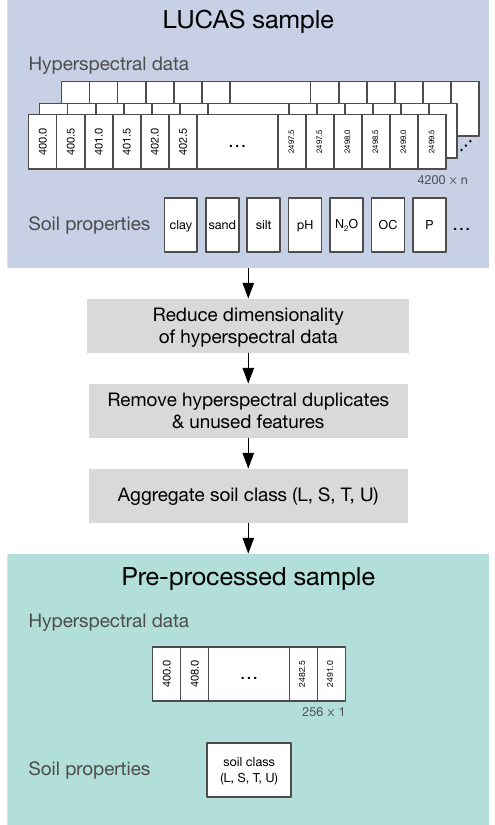
Figure 1. Preprocessing workflow with three steps: the dimension- ality reduction, the removal of the duplicates and the aggregation of the general soil classes.